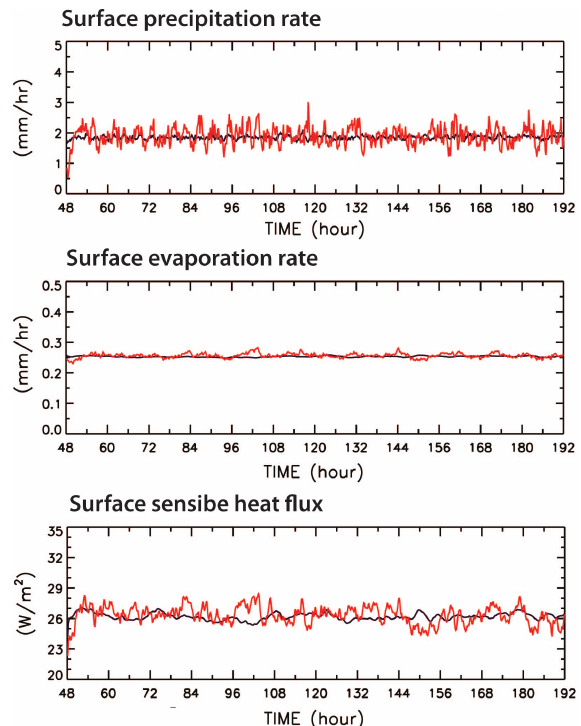
Fig. 13. Time series of domain-averaged precipitation, evaporation and sensible heat flux at the surface simulated by the Q3-D CRM (red lines) and by the BM (black